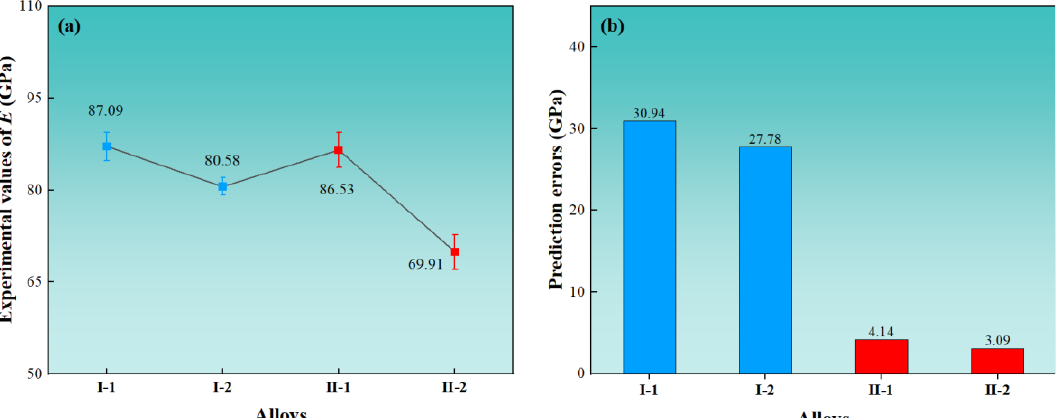
Figure 9. Comparing experimental and predicted results of Young’s modulus of Ti–Mo–Nb–Ta–Zr– Sn alloys. ( a ) Young’s modulus of the alloys was measured by the nanoindentation test, and ( b ) prediction errors of machine learning.